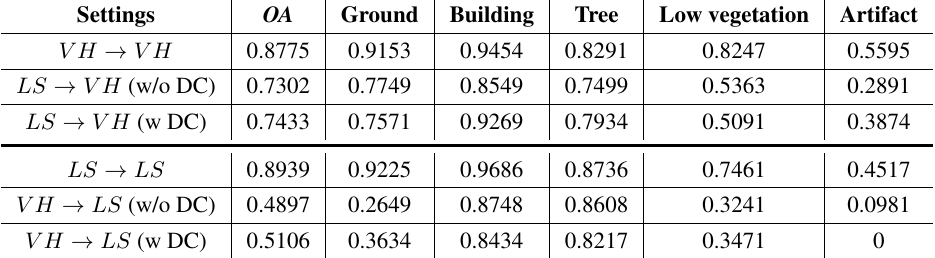
Table 4. Results without data augmentation ( l = 0 . 5 m). Intensity features were not used.